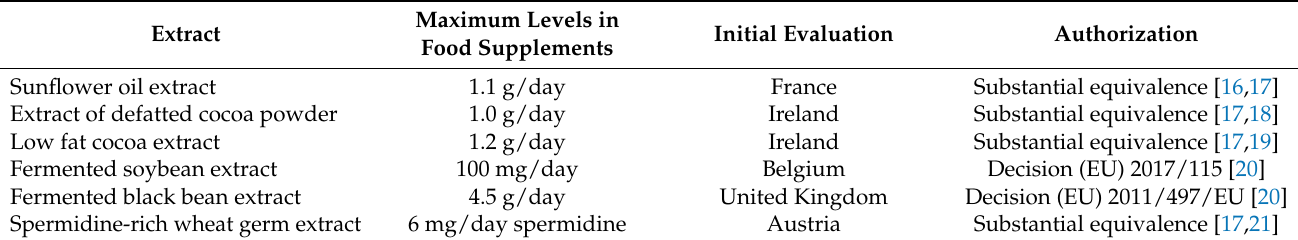
Table 1. Seed extracts authorized as novel foods for its use in food